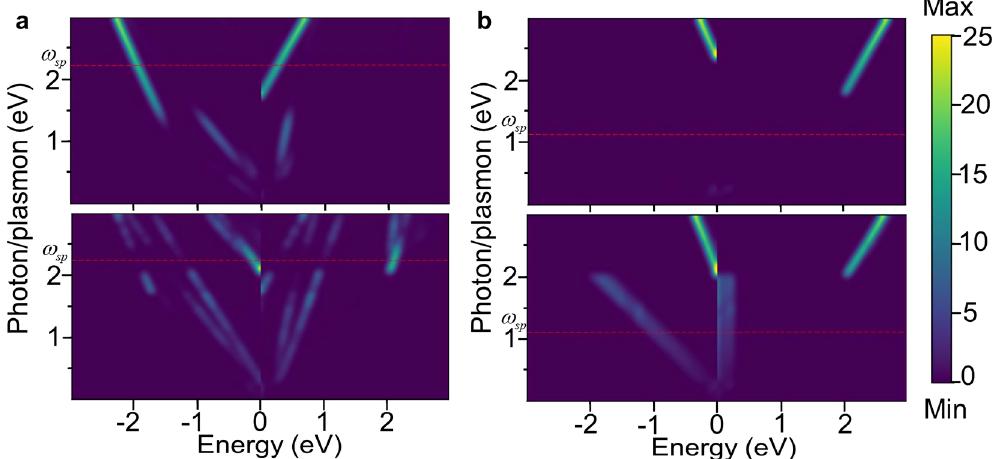
Figure 7: The energy distribution of hot carriers generated by direct interband (upper panels) and phonon-assisted intraband (lower panels) electronic transitions along with X -direction (a) and Y -direction (b) in the fi rst Brillouin zone. The horizontal axis indicates the energy of photon/plasmon-generated carrier, and negative values for hot holes and positive for hot electrons. The red lines indicate the values of surface plasmon frequency ω sp . The color bar indicates the distribution probabilities of hot carriers and the probability increases from purple to yellow. The Fermi energy is set to 0